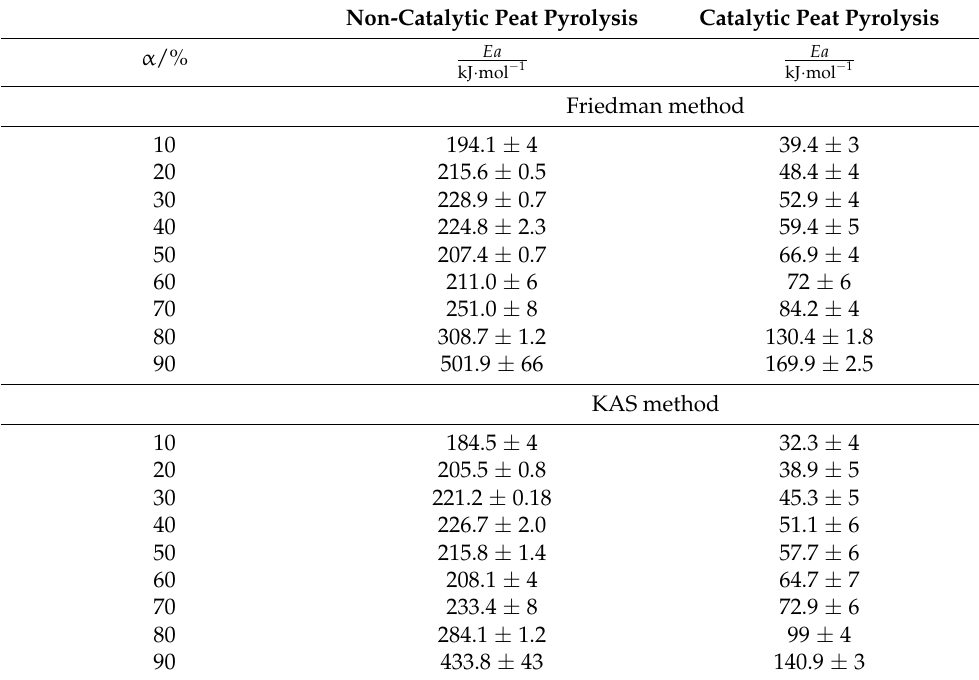
Table 3. Activation energies of catalytic and non-catalytic pyrolysis process based on KAS and Friedman methods.